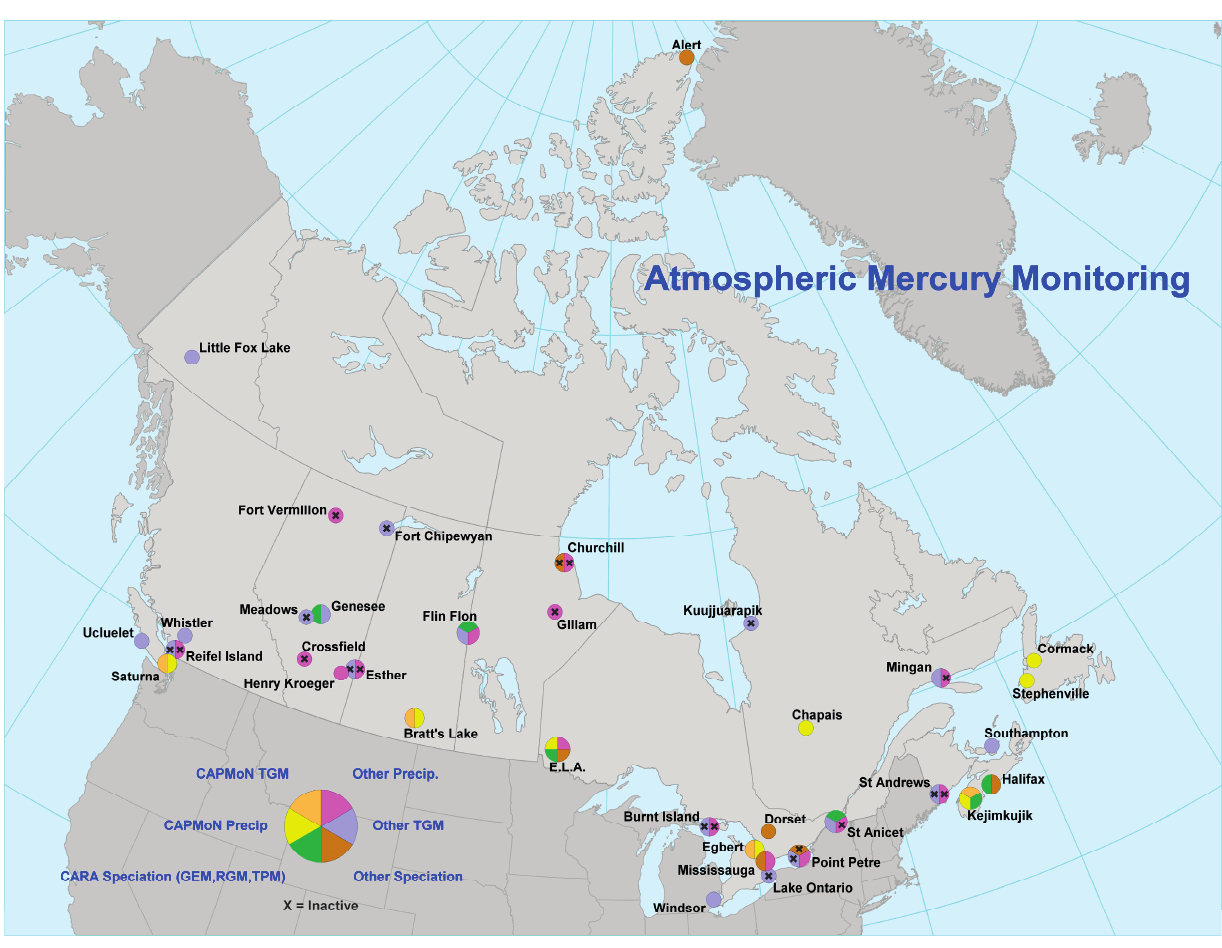
Figure 1. Map of current and past Canadian Hg monitoring